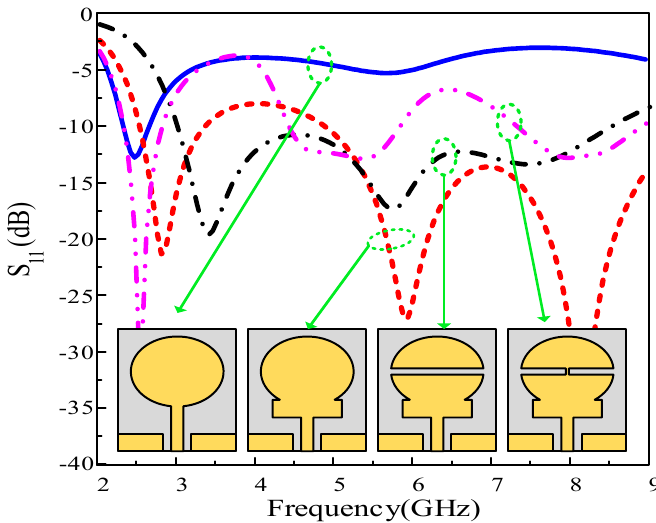
Figure 3. |S 11 | comparison among various steps included in the antenna design.